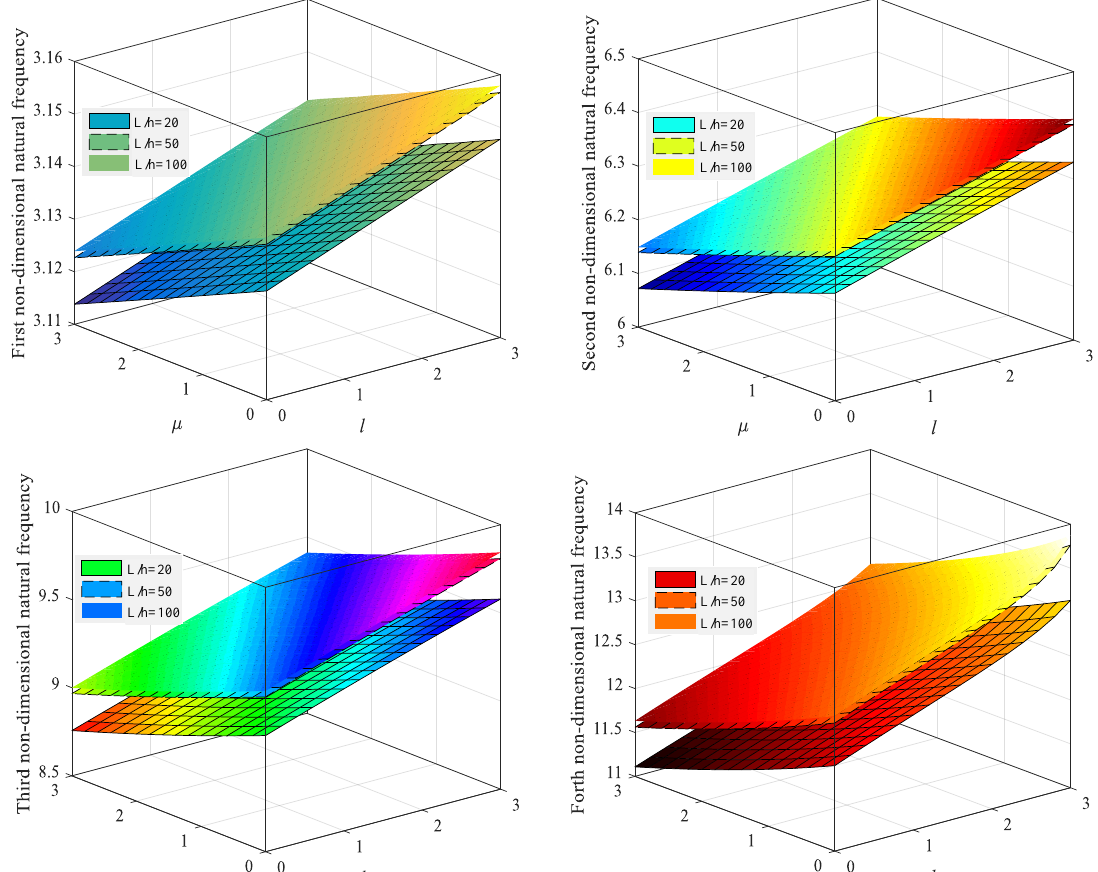
Figure 2. Variation of the first four natural frequencies for different L/h and small-scale parameters (simply-simply supported nanobeam). Table 4. Effect of the L/h and small-scale parameters on the natural frequencies for a simply-simply supported triclinic nanobeam.